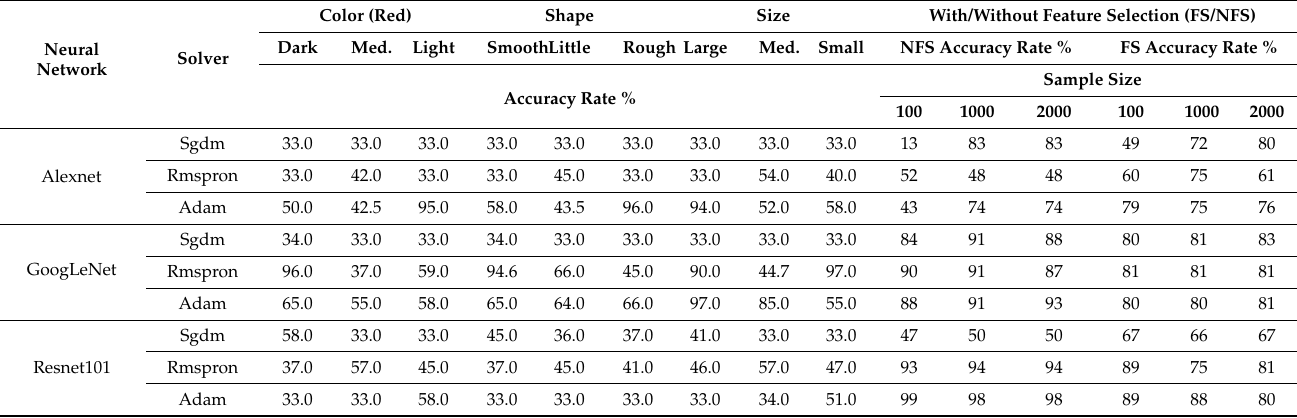
Table 6. Total accuracy rate outcomes for validation from the three NN